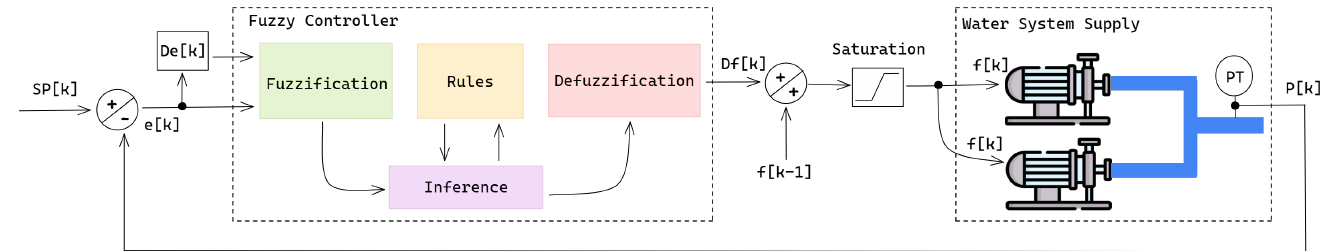
Figure 2. Fuzzy pressure control